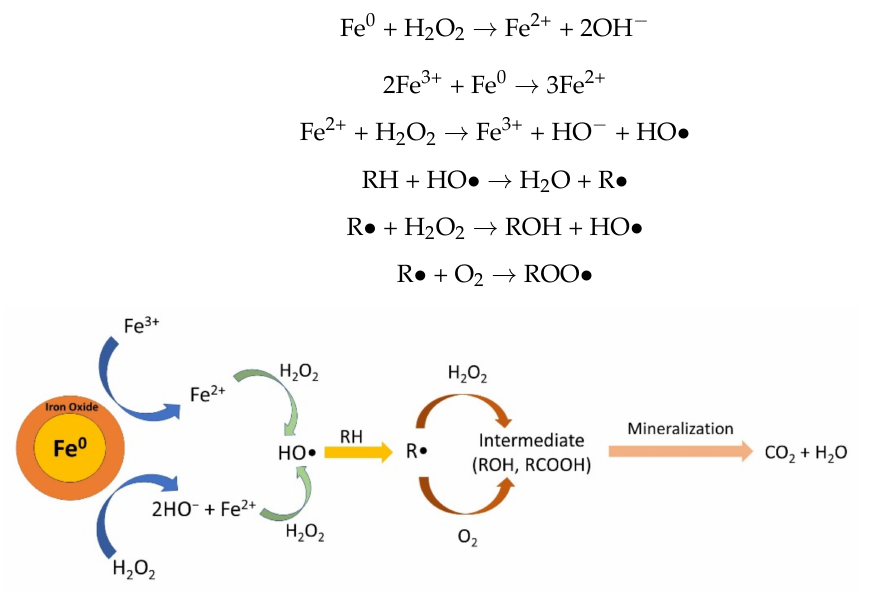
Figure 10. Mechanism of heterogeneous Fenton reactions with ZVI.